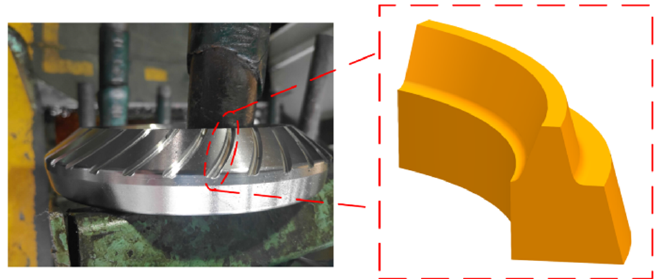
Figure 4. Simplified workpiece model.